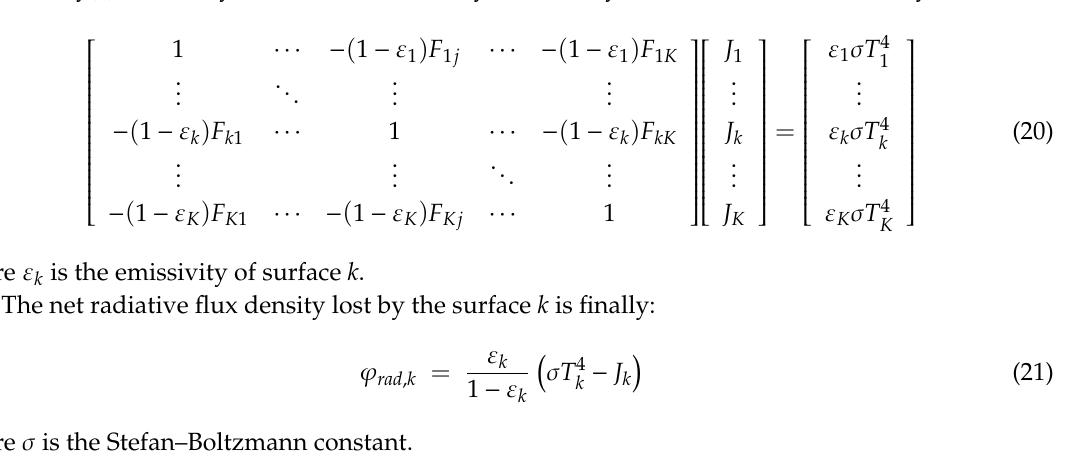
Figure 8. Meshing of the domain above the crucible top including the bar tip for radiative calculation purpose, the meshing of the charge is addressed in Section 3.3. All the shape factors 𝐹 𝑗𝑘 between surfaces j and k can be derived from geometrical considerations. The radiosity 𝐽 𝑘 emitted by each surface k is readily obtained by the inversion of the radiosity matrix [15]: